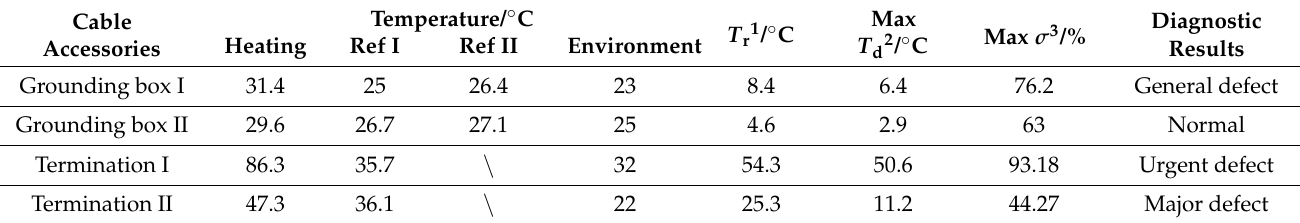
Table 3. Temperature calculation and diagnostic results of cable accessories.